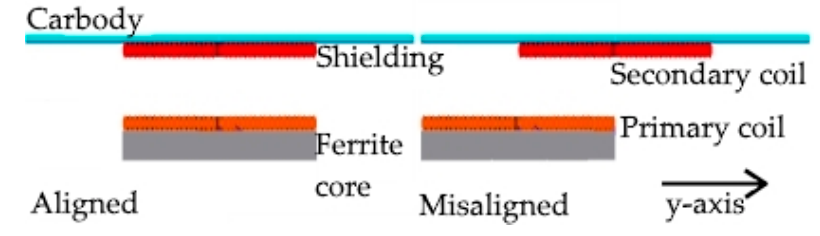
Figure 3. Diagram showing coil misalignment.